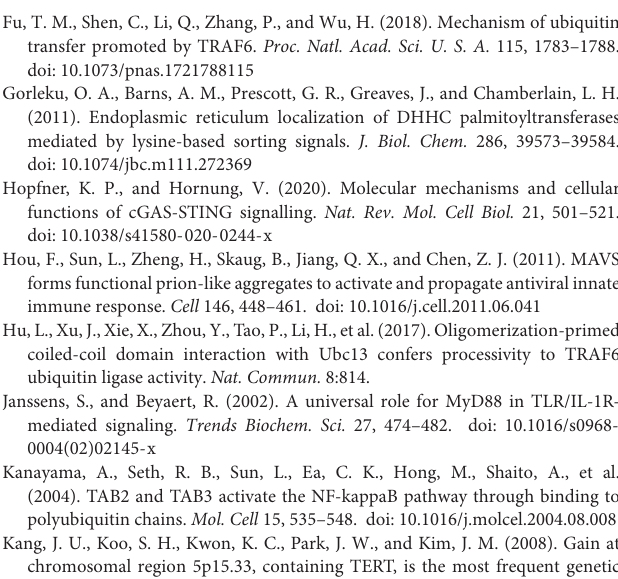
Supplementary Figure 1 | Identification of ZDHHC11 as a positive regulator in NF- κ B signaling. Supplementary Figure 2 | ZDHHC11 overexpression activates NF- κ B downstream genes in HeLa cells. Supplementary Figure 3 | ZDHHC11 knockdown reduces NF- κ B activation stimulated by IL-1 β in HeLa cells. Supplementary Figure 4 | Zdhhc11 deficiency reduces NF- κ B activation stimulated by IL-1 β , LPS, and DNA virus infection. Supplementary Figure 5 | TRAF6 interacts with ZDHHC11 through its TRAF C domain. Supplementary Figure 6 | C-terminal (198-412aa) region of ZDHHC11 plays an important role in enhancing TRAF6 oligomerization. Supplementary Figure 7 | IL-1 β treatment has no effect on the mRNA level of ZDHHC11 and association with